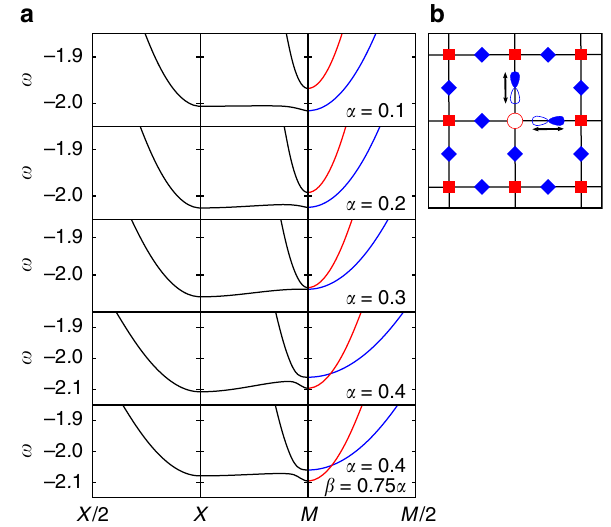
Fig. 1 Polaron spectrum at various electron – phonon couplings (color online). a The in fi nitely long-lived polaron bands obtained from the spectral function A γ , γ ( k , ω ). For M → M /2 the symmetry of the bands is indicated in blue for p + and red for p − . Parameters are t sp = − 1, t pp = − 0.49, ϵ s = ϵ p = 0, Ω = 1 and α = 0.1 … 0.4. In the bottom panel β = 0.75 α , in all other panels β = α /2. ( b ) The Lieb lattice. Arrows indicate the direction of oscillation of the